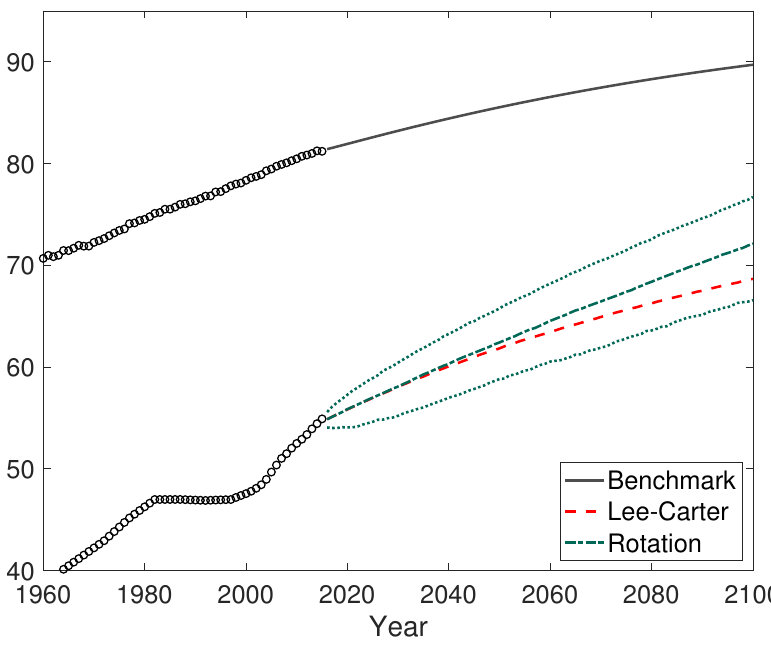
Figure A6. The average projected life expectancy of the benchmark countries and Nigeria using the rotation algorithm and the independent Lee–Carter